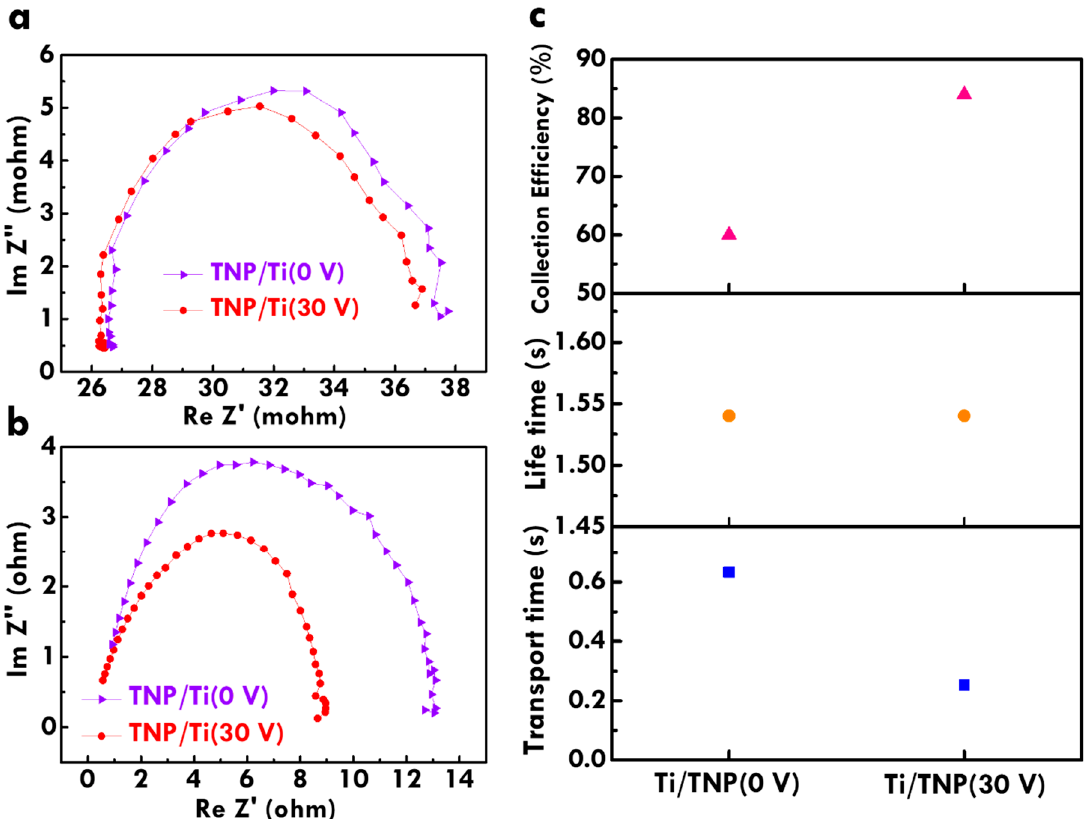
Figure 6. ( a ) IMPS spectra, ( b ) IMVS spectra and ( c ) relation of the transport time, lifetime, and collection e ffi ciency to anodization voltage for preparing the substrate of photoanodes for FDSSC with TNP / Ti wire and TNP / TNT-printed Ti wire